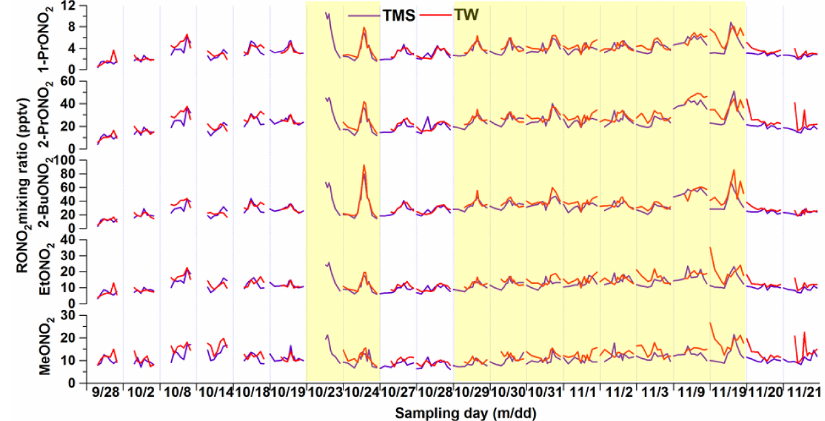
Figure 3. Time series of MeONO 2 , EtONO 2 , 1-PrONO 2 , 2-PrONO 2 and 2-BuONO 2 measured at TMS (purple) and TW (red) in 2010. The yellow shading highlights the O 3 episode days.